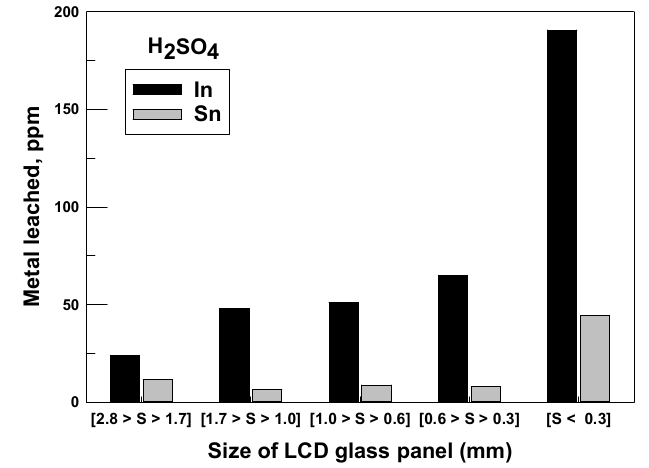
Figure 5. Leaching behavior of indium and tin as a function of the size of the cullet pieces, as classified by sieving using 5 M H 2 SO 4 as the lixiviant.